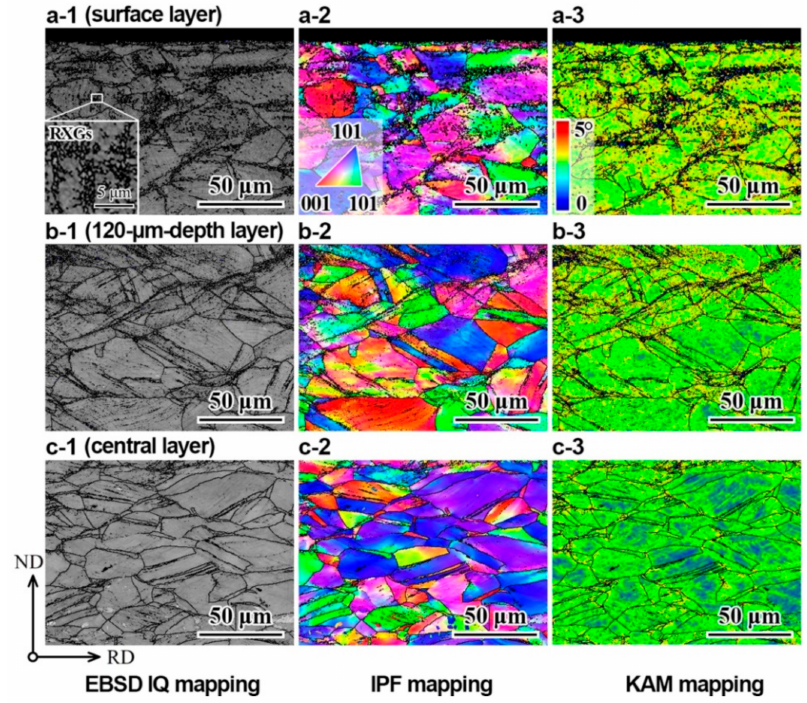
Figure 1. EBSD images of the GS2 sample prior to tensile testing: ( a1 – a3 ) IQ, IPF and KAM mappings for the surface layer; ( b1 – b3 ) IQ, IPF and KAM mappings for the layer with a depth of 120 µ m; ( c1 – c3 ) IQ, IPF and KAM mappings for the central